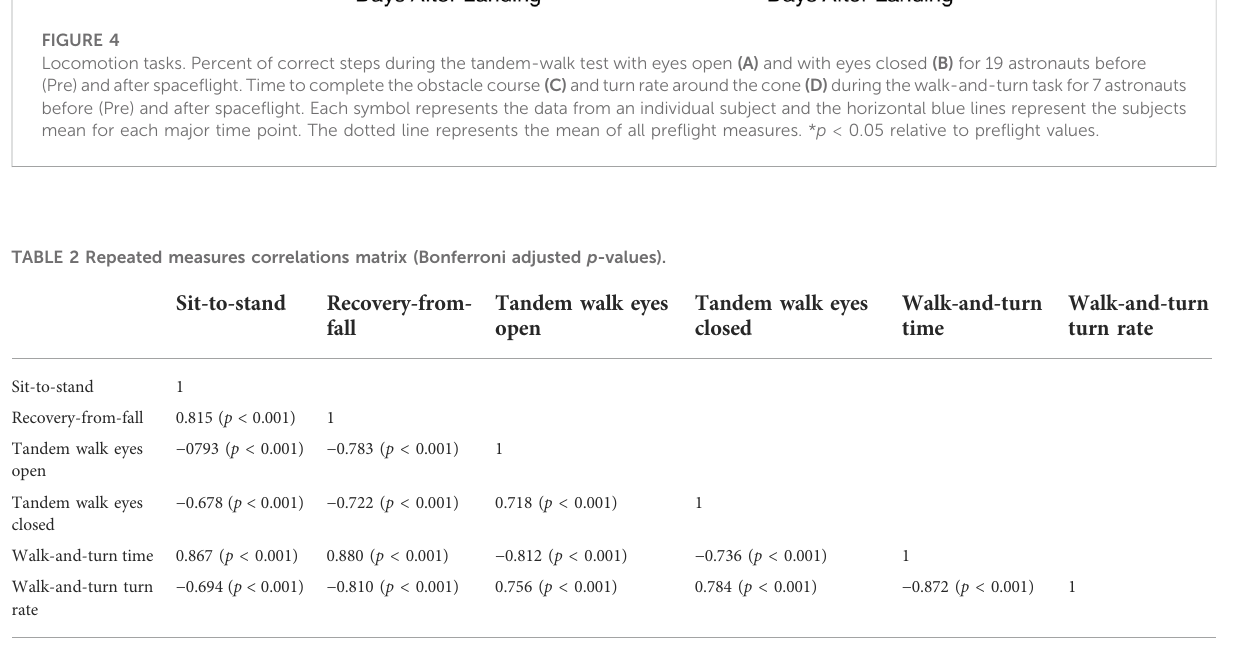
TABLE 2 Repeated measures correlations matrix (Bonferroni adjusted p -values). Sit-to-stand Recovery-from- fall